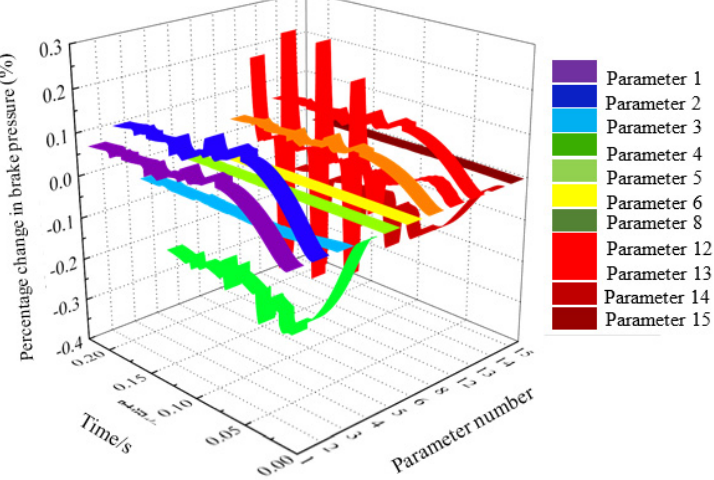
Figure 7. The change of x 8 with amplifier parameter varieties by 10%.